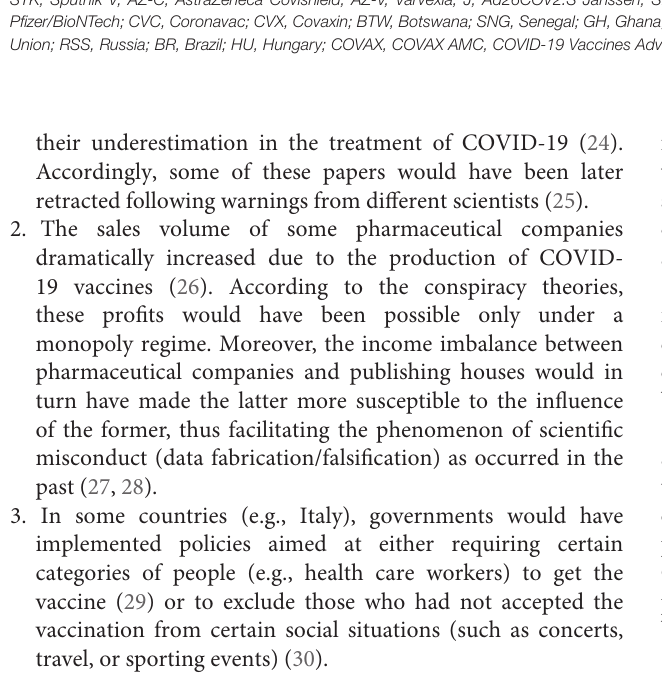
STK, Sputnik V; AZ-C, AstraZeneca Covishield; AZ-V, Varvexia; J, Ad26COV2.S Janssen; SP, BBIP-CorV Sinopharm; M, mRNA 1273 Moderna; VPT, VidPrevTyn; CN, Comirnaty, Pfizer/BioNTech; CVC, Coronavac; CVX, Covaxin; BTW, Botswana; SNG, Senegal; GH, Ghana; EU, European Union; USA, United States of America; CH, China; IND, India; AU,